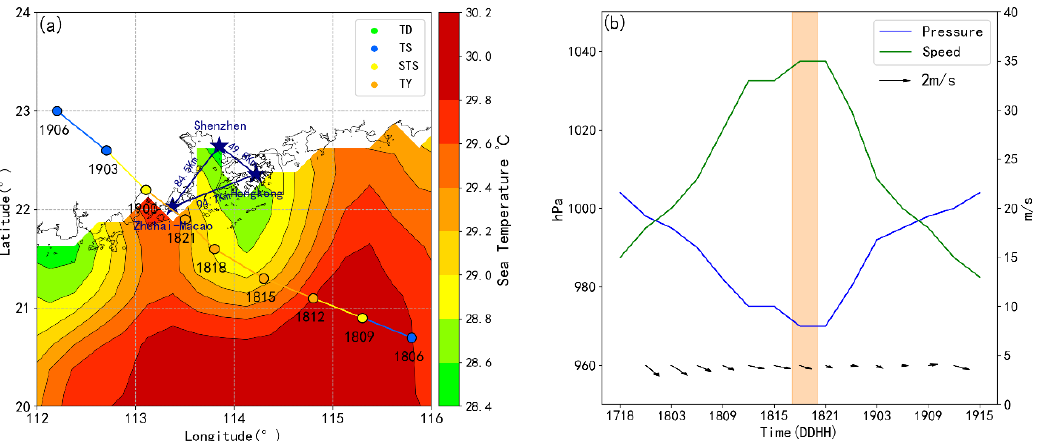
Figure 1. ( a ) The best track of Typhoon Higos and the sea surface temperature (SST) on 18 August 2020. The circled dots show 3 h intervals along the track. The dark blue asterisks denote the locations of the three radars. The SST data are from the Optimum Interpolation Sea Surface Temperature (OISST) Dataset of the National Oceanic and Atmospheric administration (NOAA) National Climatic Data Center (NCDC). The best track data are from the CMA website https://tcdata.typhoon.org.cn (accessed on 6 March 2021). ( b ) Temporal evolution of Higos’ intensity. The blue line indicates the central pressure from the best track data. The green line indicates the 2 min averaged maximum wind from the best track data. The vector arrows represent the VWS of 200–850 hPa, which is calculated by the wind shear within a 500 km radius of the typhoon center from the reanalysis data of the European Centre for Medium Range Weather Forecasts (ECMWF). The vertical orange rectangle represents the analyzing periods of this paper.